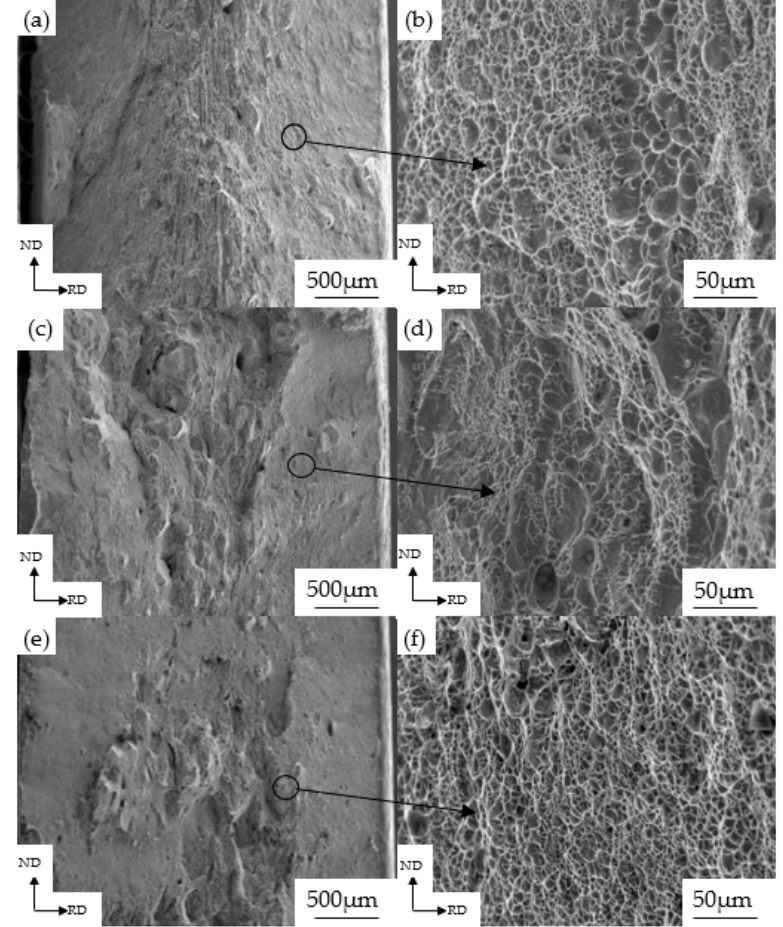
Figure 9. Tensile fracture morphology of the experimental steel quenched ( a , b ) and cold rolled to a reduction of 10% ( c , d ) or 30% ( e , f ). a reduction of 10% ( c , d ) or 30% ( e , f